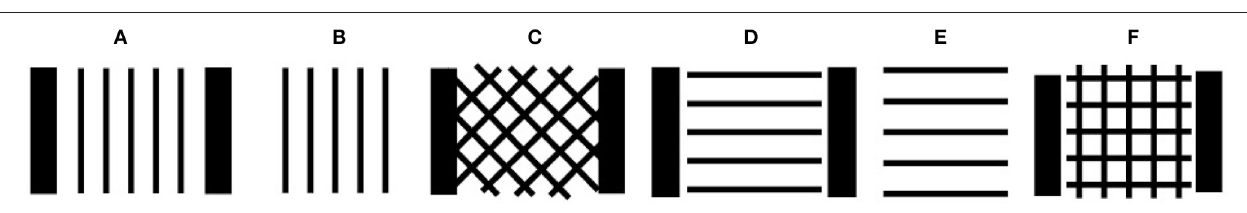
chosen over the strain gauges because it allows quicker placement et al., 2014). The load cell uncertainty was also 0.5% The cross calipers with 0.02 mm